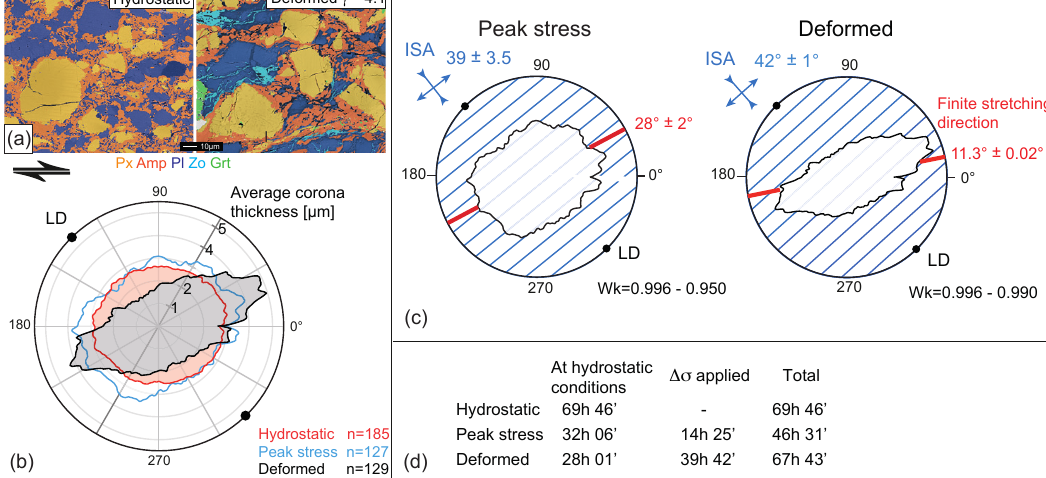
Figure 13. Analysis of amphibole coronas. Thickness of amphibole (Amp) corona on pyroxene (Px) porphyroclasts as a function of orien- tation from Maryland diabase experiments deformed at Pc ≈ 1 . 5GPa. (a) Phase map of microstructure developed when no (cid:49)σ was applied (“hydrostatic”) and in the case of sample deformation ( (cid:49)σ > 0, “deformed”). (b) Average Amp corona thickness presented as a rose diagram; n : number of analyzed coronas. Analysis for three different samples are presented:“hydrostatic”, “peak stress” ( γ a ∼ 0 . 6), and “deformed” ( γ a ∼ 4). (c) Duration of experiments in hours (h) and minutes ( (cid:48) ). (d) Kinematic analysis of panel (b) ; blue lines indicate calculated instan- taneous stretching directions. In red is the calculated finite stretching direction; LD: loading direction. Wk: kinematic vorticity number. The error range in the ISA direction, finite stretching direction, and Wk is caused by the uncertainty of the starting thickness of the shear